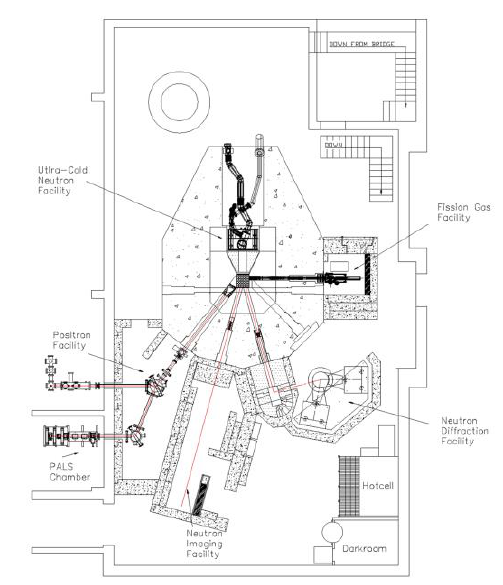
Fig. 1. PULSTAR bay floor and beamport experimental